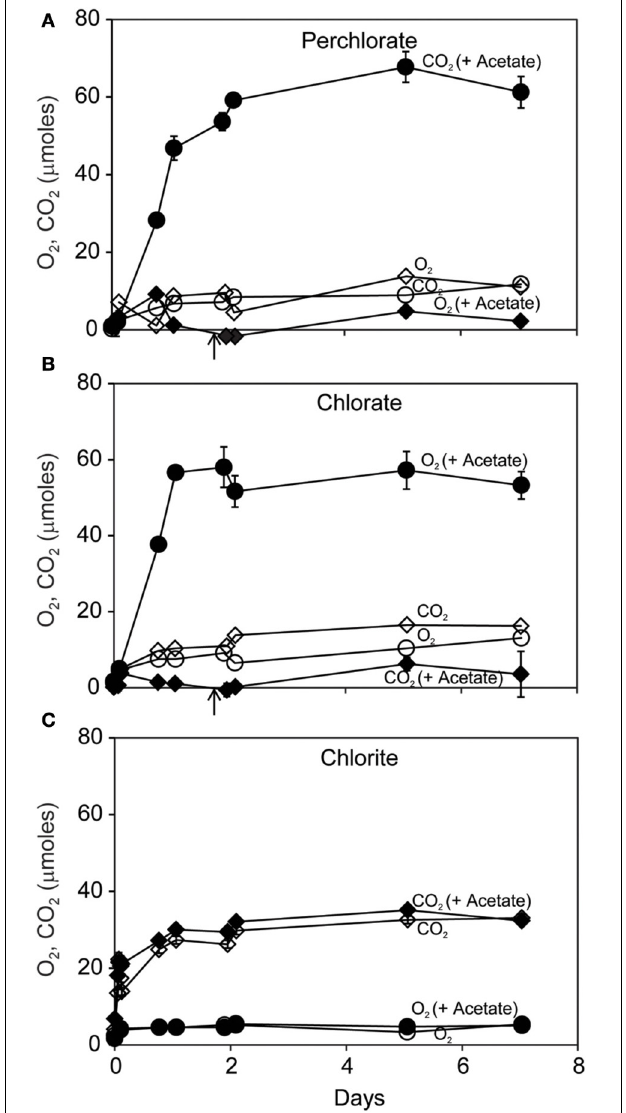
FIGURE 2 | Time course of reaction of D. agitata CKB following addition of10mMClO − 4 (A),ClO − 3 (B),orClO − 2 (C)showingproductionofgaseous products O 2 (diamonds) and CO 2 (circles), with (solid symbols), and without (open symbols) 5mM acetate. Solid symbols represent the mean and range of duplicate samples. Absence of bars indicates that the error is smaller than the symbol size. Open symbols represent single samples. Arrows in (A) and (B) correspond to the time when 5mM added acetate was completely